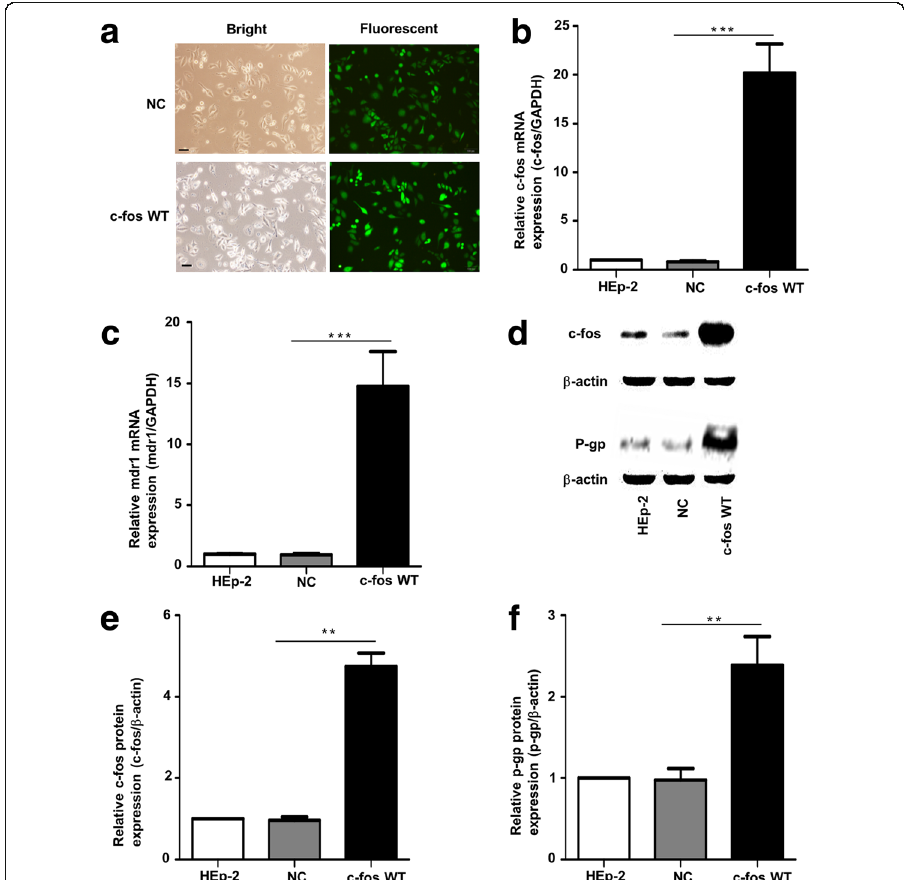
Fig. 2 Expression of mdr1 and p-gp in HEp-2 cells after overexpression of c-fos. a Fluorescence microscopy examination of the efficiency of transfecting the c-fos overexpression plasmid into HEp-2 cells (named c-fos WT). The negative control (NC) was HEp-2 cells transfected with an empty vector. The scale bar represents 100 μ m. b , c Real-time PCR results showing the expression of c-fos and mdr1 in HEp-2 cells after the overexpression of c-fos. d Western blot results showing the expression level of c-fos and p-gp in HEp-2 cells after the overexpression of c-fos. e , f The statistical quantification analyses of c-fos and p-gp protein levels in c-fos overexpression HEp-2cells.Data are shown as the means ±SD. **p < 0.01, *** p <